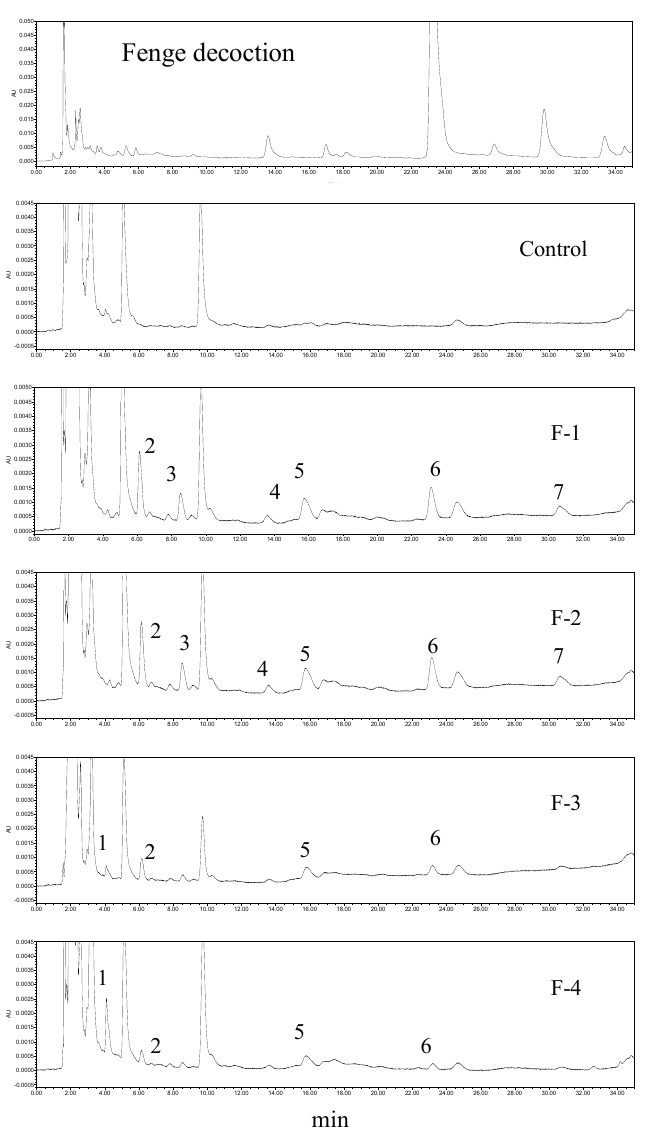
Figure 5. Fenge water decoction fingerprint and plasma fingerprints after rabbits were treated with different concentration of F-1, F-2, F-3, and